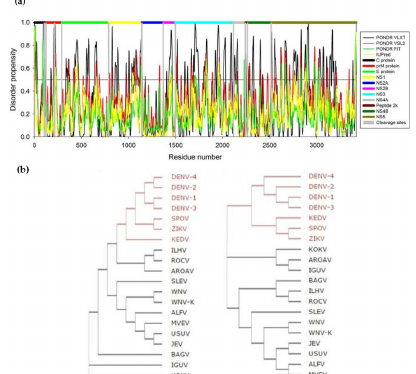
Figure 3. Flavivirus polyprotein disorder propensity. ( a ) The Flavivirus proteome is rich in structurally disordered regions (values scored above 0.5 in the graph). ( b ) Flaviviruses use disordered protein regions to extract more function out of a small genome. One such proteins is the C protein, which amino acid residues sequence variability (left) is representative of that of the polyprotein (right). The same clades within mosquito-borne flaviviruses are observed. Abbreviations: SPOV—Spondweni virus; KEDV—Kedougou virus; ILHV—Ilheus virus; ROCV—Rocio virus; AROAV—Aroa virus; SLEV—Saint Louis encephalitis virus; WNV-K—WNV serotype Kunjin; ALFV—Alfuy virus; MVEV—Murray Valley encephalitis virus; USUV—Usutu virus; BAGV—Bagaza virus; IGUV—Iguape virus; KOKV—Kokobera virus. Adapted with permission from